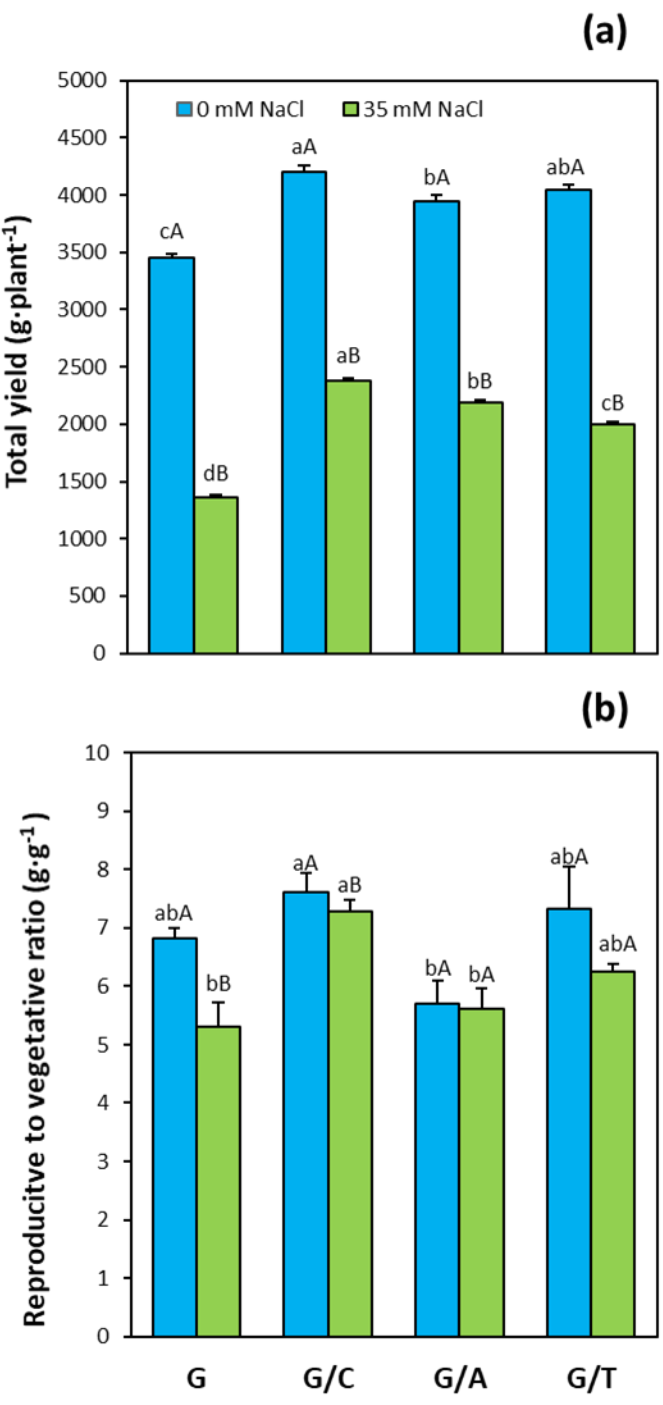
Figure 3. ( a ) Total yield, and ( b ) reproductive to vegetative ratio of pepper plants of the commercial variety “Gacela F1” either non-grafted (G) or grafted onto the commercial rootstocks, Creonte (G/C), Atlante (G/A), and Terrano (T/A), and cultivated under control (0 mM NaCl) and salinity (35 mM NaCl) conditions. Bars show the means of five plants ± standard error. Different capital letters indicate significant differences due to the salt treatment while different small letters show significant differences among graft combinations according to Tukey’s test ( p ≤ 0.05).